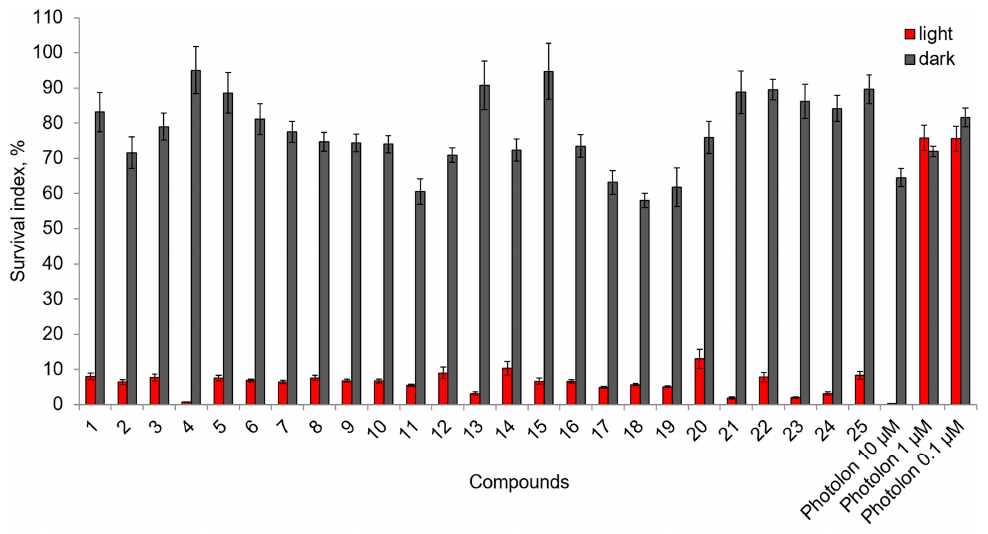
Figure 2. Photoinduced cytotoxic activity of chlorophyll-a derivatives (1 μ M) and of Photolon TM (0.1, 1 and 10 μ M) activated by 660 nm light (2 h of preincubation then 20 min light exposure followed by incubation in the dark for 70 h).